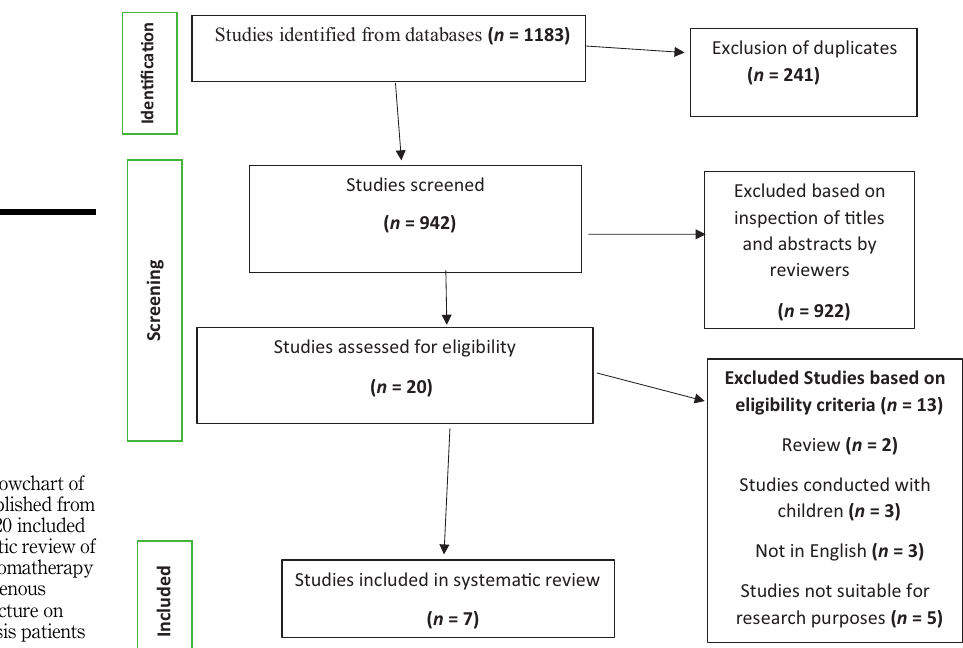
Figure 1. PRISMA flowchart